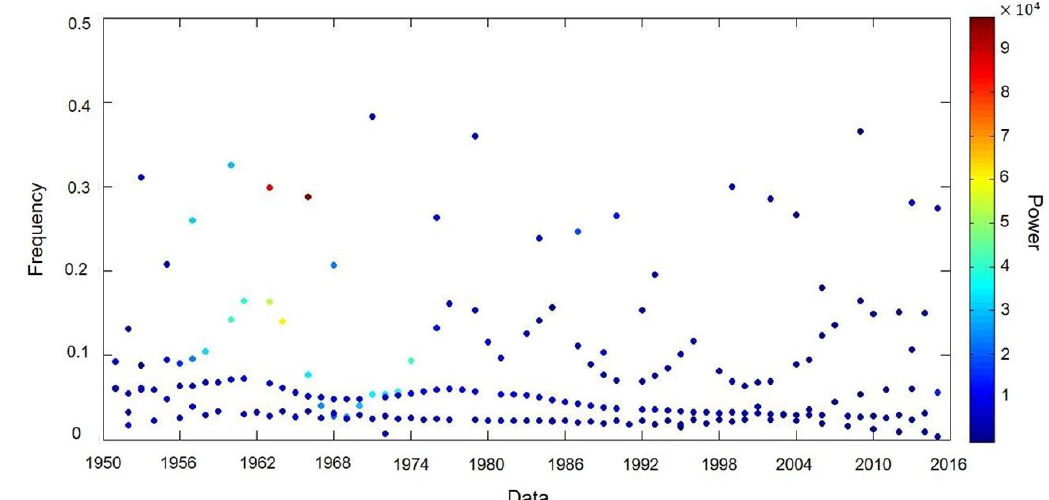
Figure 16. The Hilbert spectrum for the 66a series of LHS.